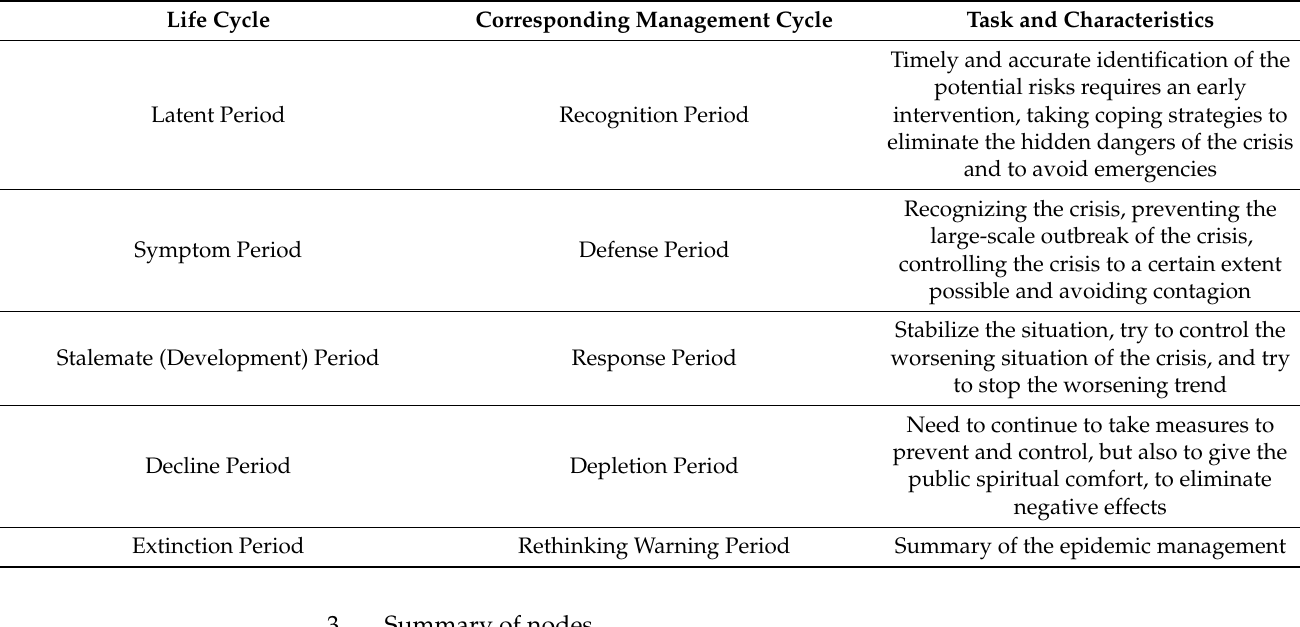
Table 8. Division conditions and characteristics of COVID-19 management